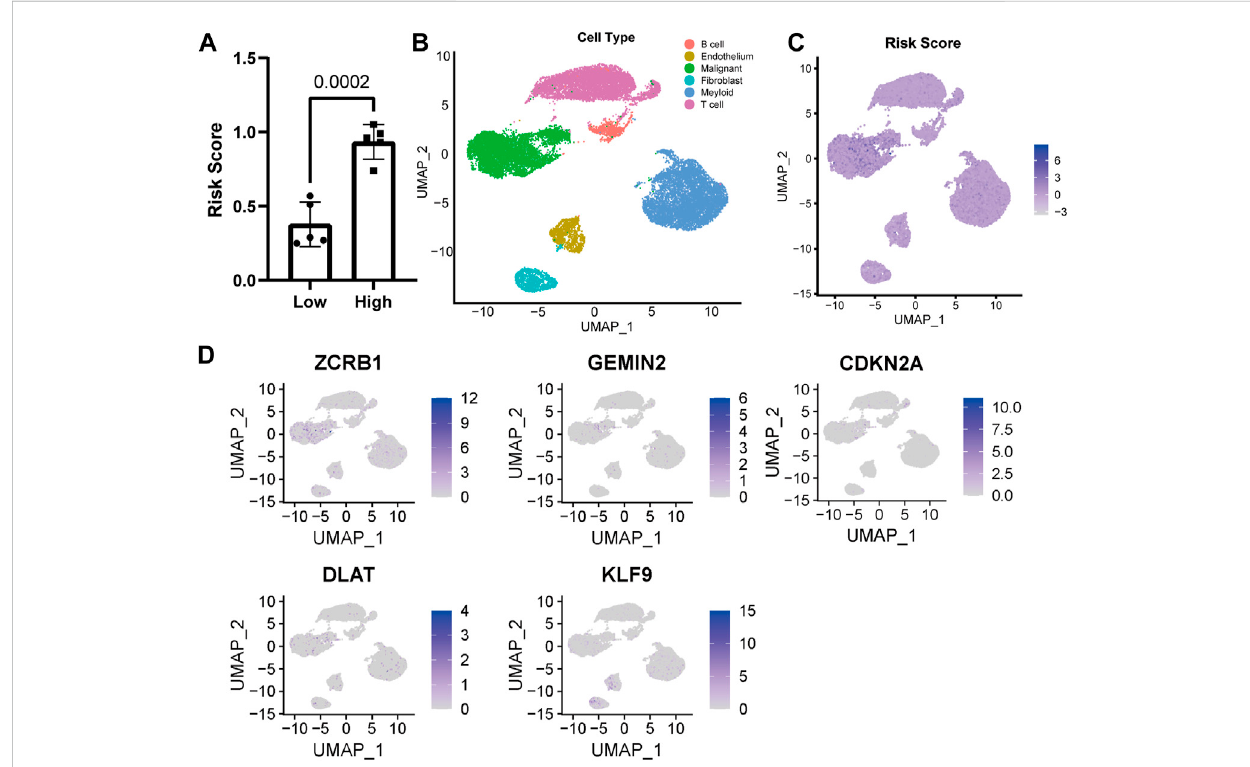
FIGURE 3 Distribution of model genes and risk score in UMAP based on single-cell sequencing data (GSE149614). (A) Comparison of risk scores of different samples. (B) UMAP of 23,590 cells from primary HCC tumors of ten HCC patients. (C) Distribution of risk score in UMAP. (D) Distribution of model construction genes in